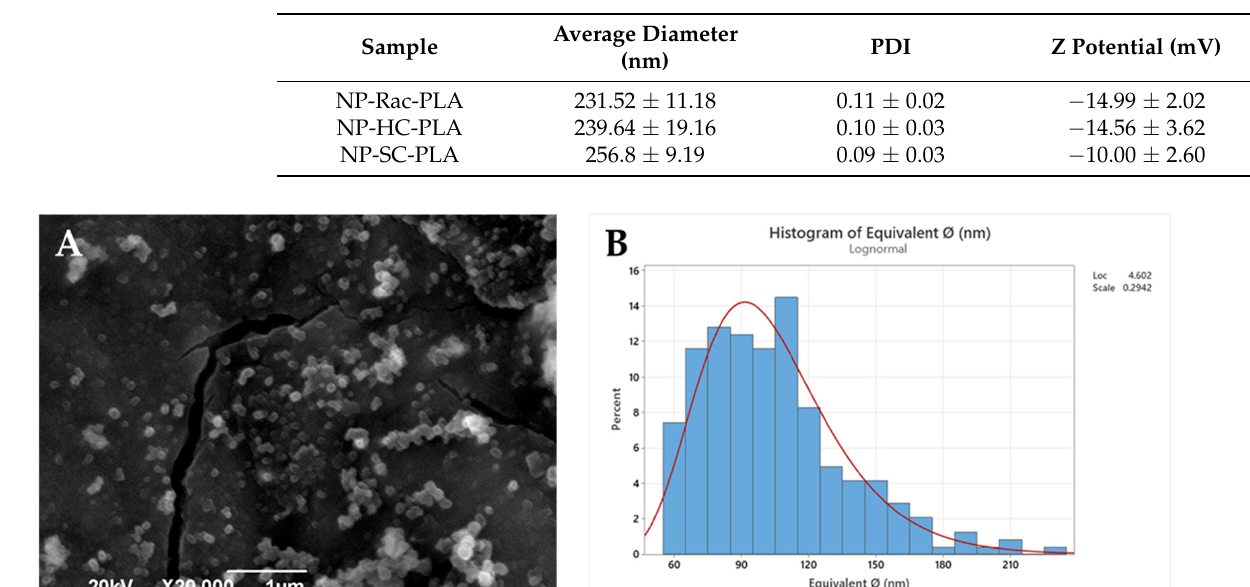
Table 2. DLS characterization of PLA nanoparticles.